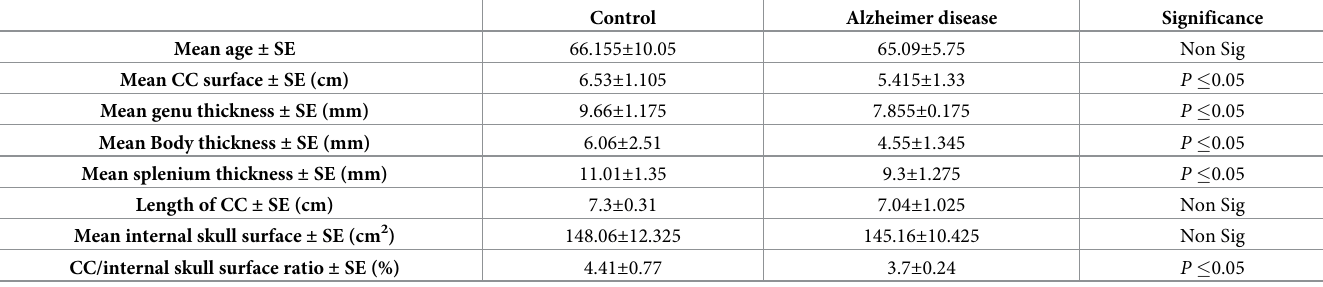
Table 2. Average CC values in Alzheimer disease individuals: Comparison with normal